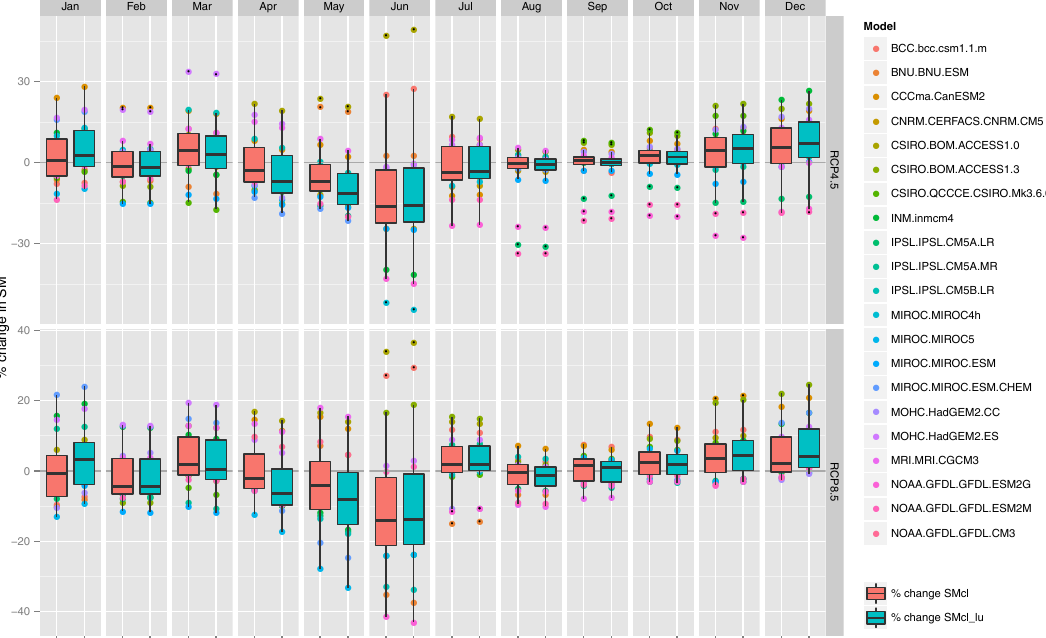
Figure B5. Percentage changes in soil moisture fluxes between the historical simulation period 2000–2005 and the future projection simula- tion period 2030–2035 for the Upper Ganges basin and for each of the emission scenarios (RCP4.5 and RCP8.5). Pink colour corresponds to the scenarios where only climate change is taken into account. Blue colour corresponds to the scenarios where both climate change and land-use change are taken into